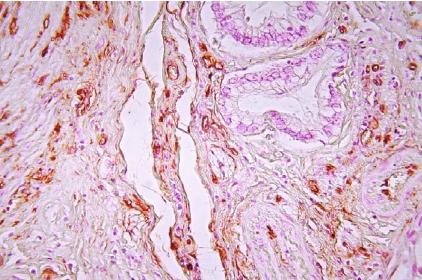
Figure 9: Pancreatic ductal adenocarcinoma, hypervascular area, immunohistochemical staining, CD 34, × 200.